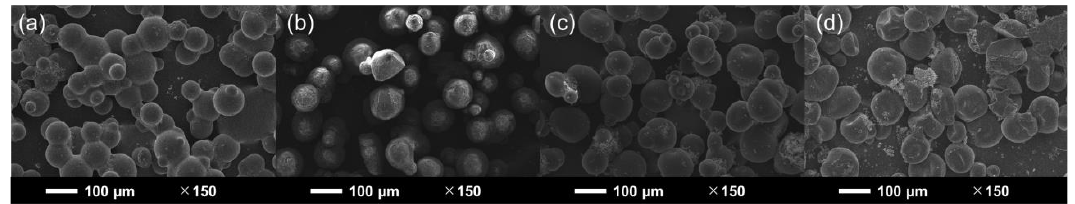
Figure 5. Powder structures after the ramping experiments at 50 °C. ( a ): Suc, ( b ): Lac, ( c ): MD (DE = 25), and ( d ):MD (DE = 19).